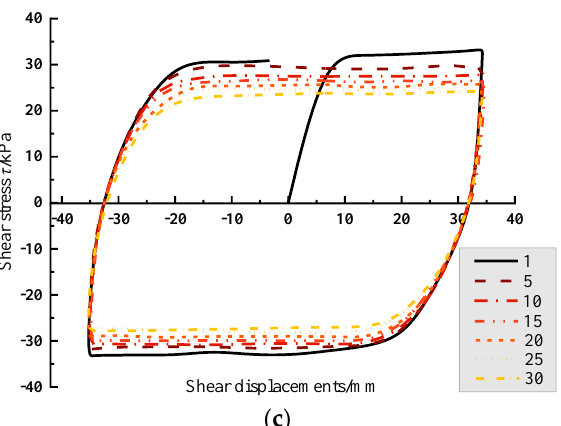
Figure 8. Shear stress-shear displacement curves with different levels of water content: ( a ) 16%; ( b ) 20%; ( c ) 24%.